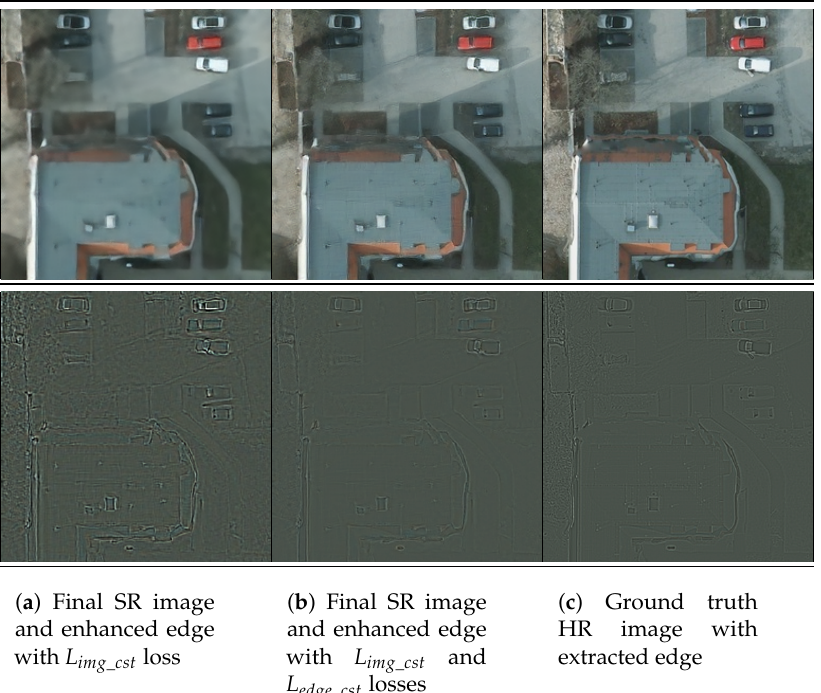
Figure 12. Effects of edge consistency loss ( L edge _ cst ) on final SR (super-resolution) images and enhanced edges compared to the extracted edges from HR (high-resolution)